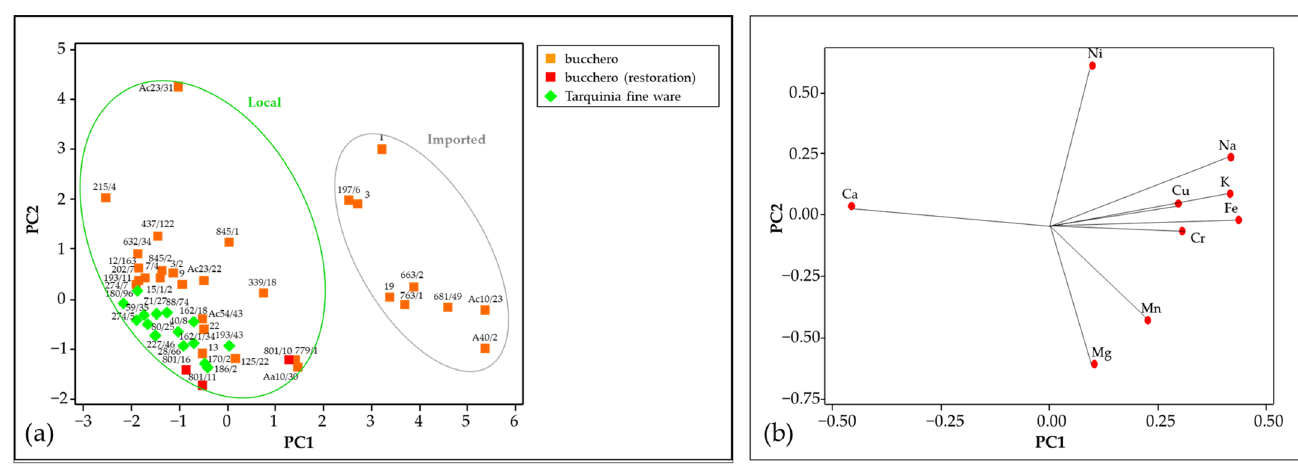
Figure 3. ( a ) Score plot of the first two principal components of the elemental composition of bucchero pottery (orange and red squares) from the excavation of La Civita di Tarquinia, compared with the locally produced fine pottery (green squares); the red squares indicate the bucchero samples examined in view of a virtual reconstruction (see text, Section 3.3); ( b ) loading plot of the principal components as in ( a ).